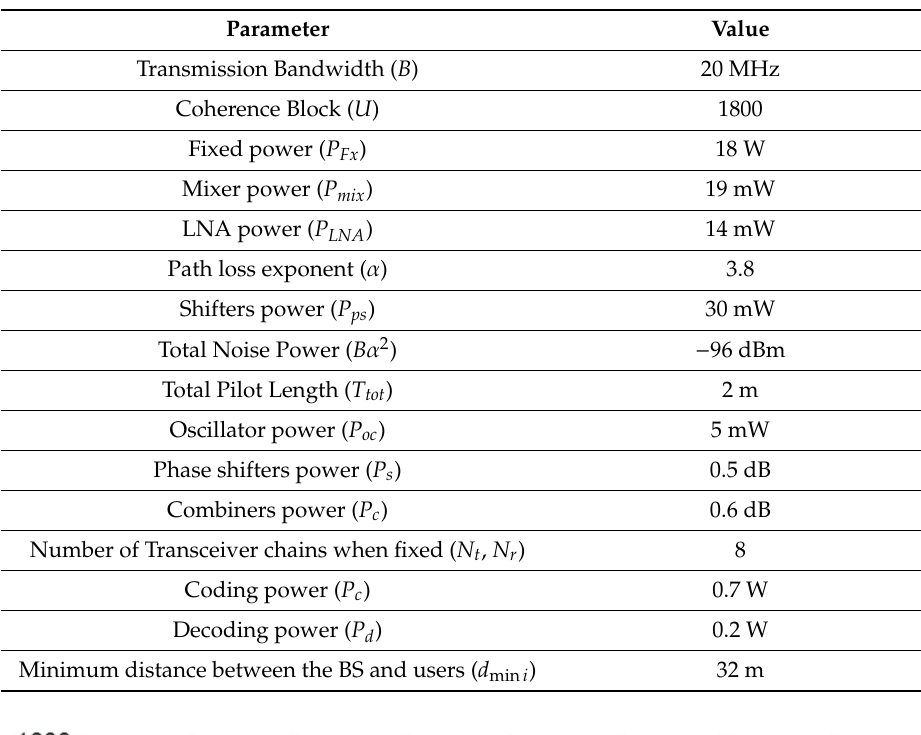
Table 1. Simulation parameters.